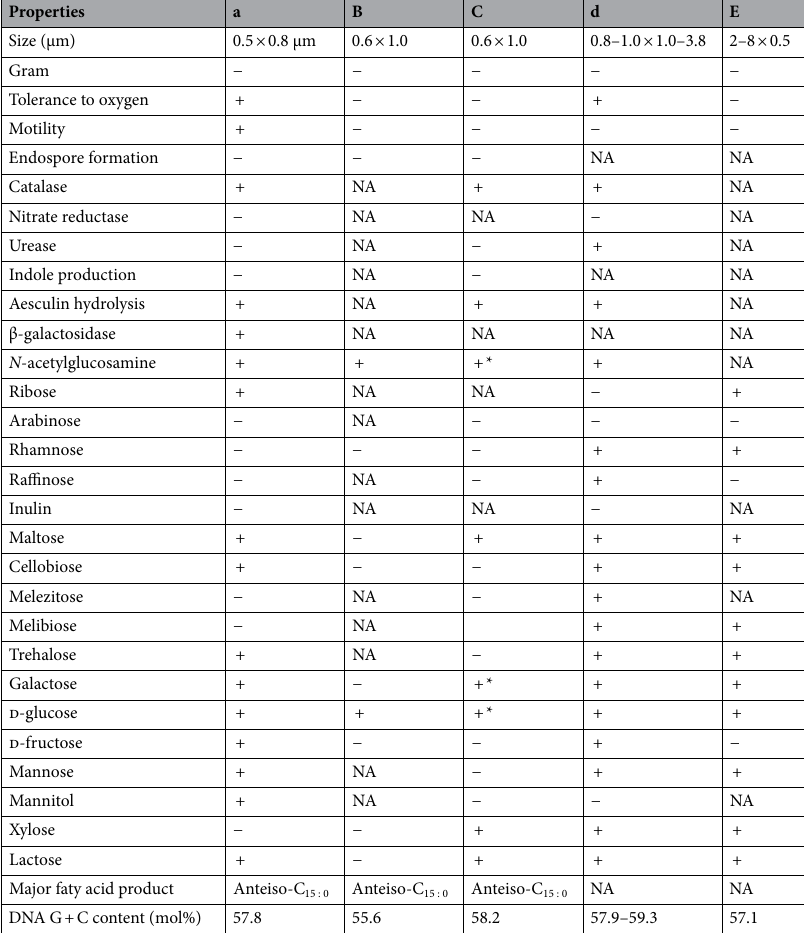
Table 1. Physiological features of Akkermansia massiliensis strain Marseille-P6666 (a), Akkermansia muciniphila strain ATCC BAA-835 T (b), Akkermansia glycaniphila strain Pyt T (c), Verrucomicrobium spinosum strain DSM4136 T (d), Prosthecobacter debontii strain ATCC 700200 T (e); (+): positive; (−): negative; (*): weak reaction; NA not available